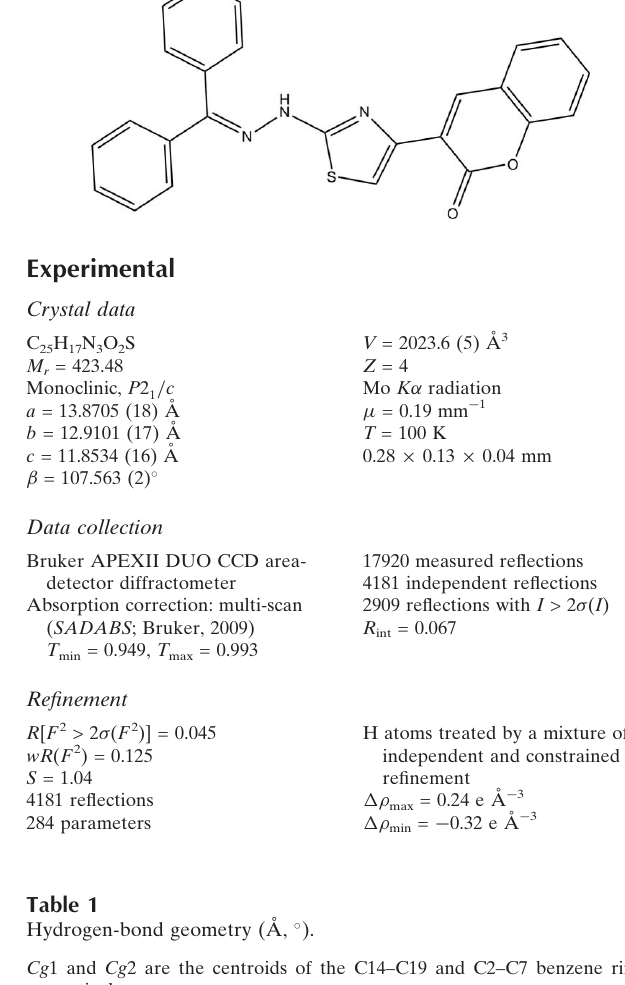
17920 measured reflections 4181 independent reflections